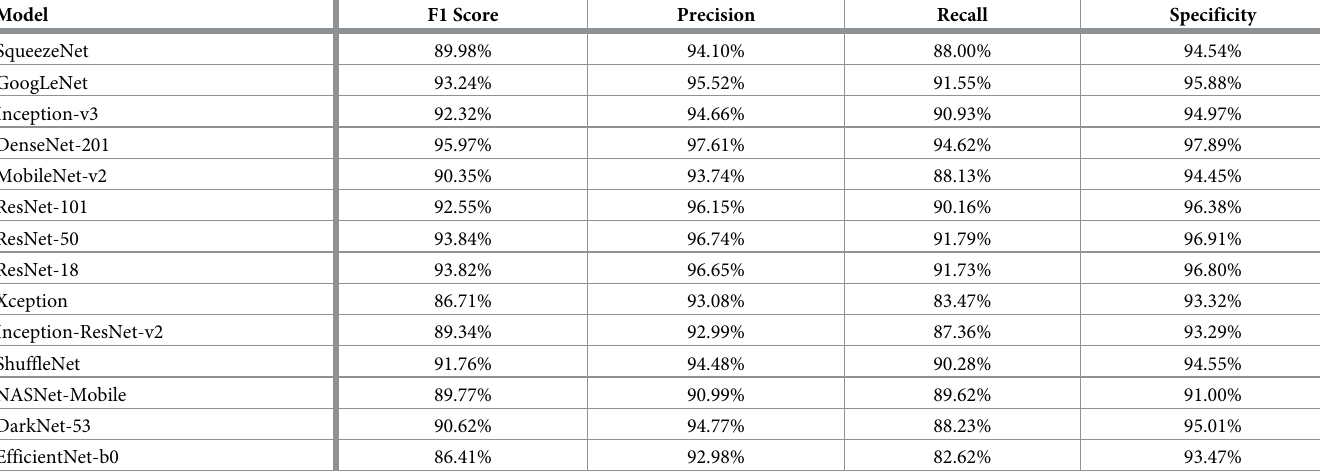
Table 2. The mean overall F1 score, precision, and recall parameters for the 14 deep learning models performing three-class classification.